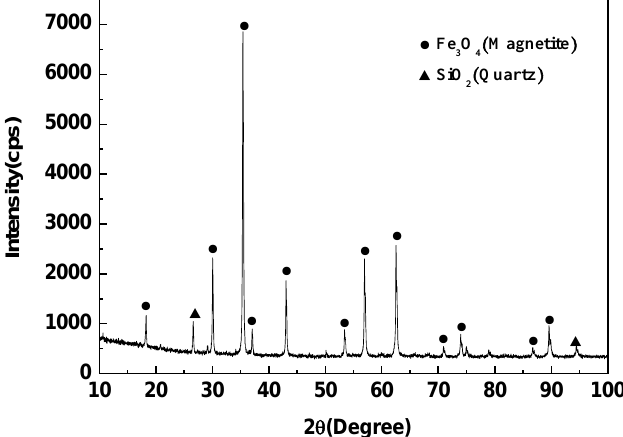
Figure 1. Results of the X-ray diffraction analysis of the iron concentrate.